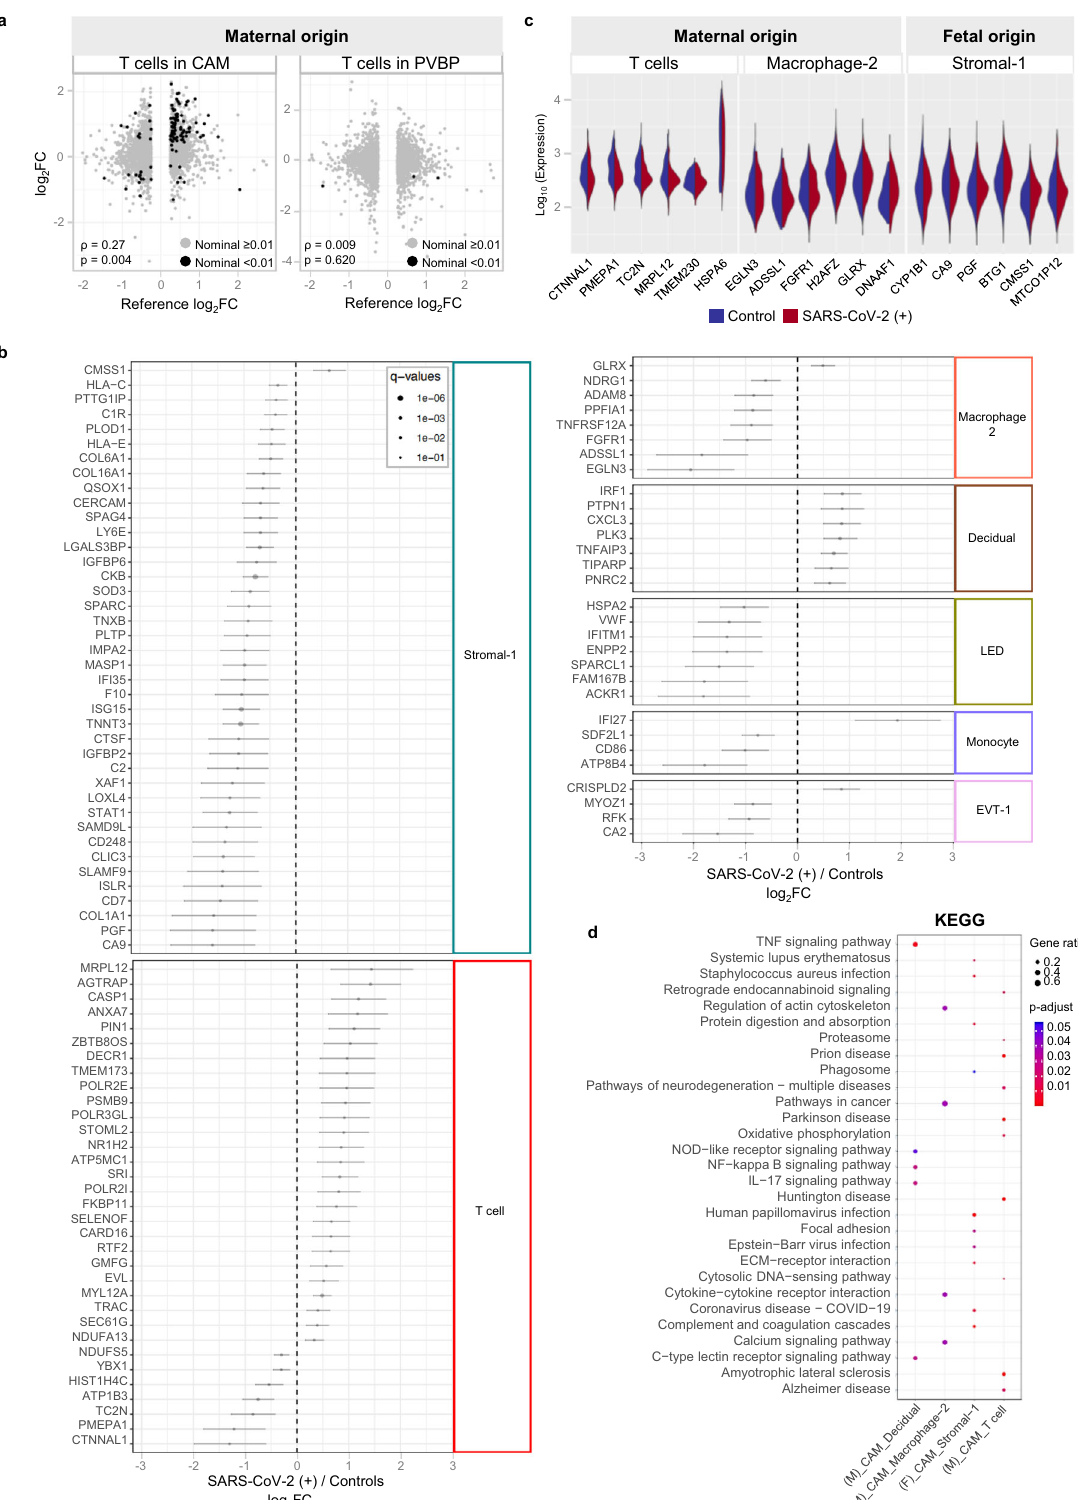
T-cell responses are altered by SARS-CoV-2; yet, pregnancy also promotes stereotypical cellular responses. Interestingly, maternal T cells from the CAM displayed enrichment of GO terms related to mitochondrial gene expression and translation, a process that has been implicated in T-cell functions including cytokine production 70